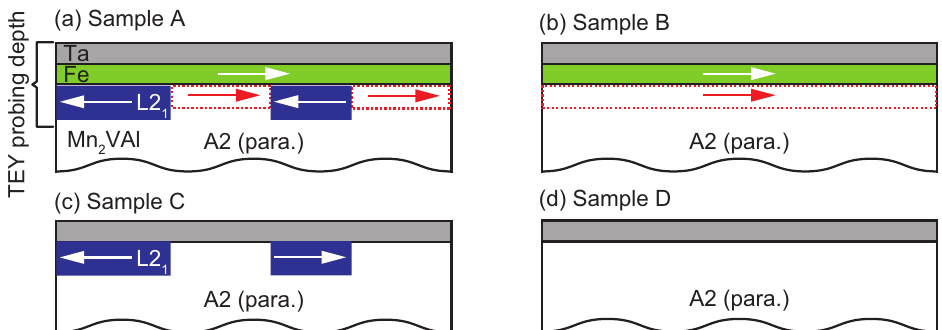
Figure 9. Schematic illustration of possible cases for the alignment of magnetic moments around the interface. For Samples A and C, the crystal grains showing the L2 1 phase are distributed inside the A2 matrix. Here, µ 0 H of 0.1 T is assumed in this Figure. In Samples ( a ) A and ( b ) B, the magnetic moments of Mn 2 VAl antiferromagnetically couple with that of Fe for the L2 2 grains, whereas the induced moments in the A2 phase couple ferromagnetically. ( c ) In Sample C, although spontaneous moments occur inside the L2 1 grain, those possibly align antiferromagneticaly, which results in no XMCD at 0.1 T. ( d ) In Sample D, no spontaneous magnetization